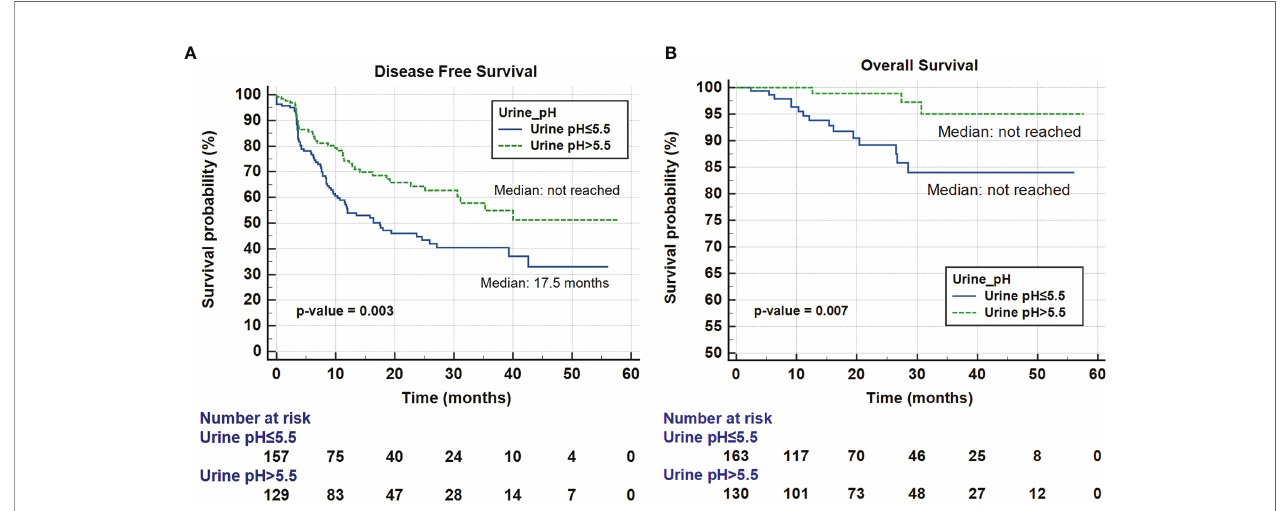
FIGURE 1 | Kaplan-Meier curve of the effect of low urine pH ( ≤ 5.5) (blue) and high urine pH (> 5.5) (dotted green) groups on disease-free survival (A) and overall survival (B)